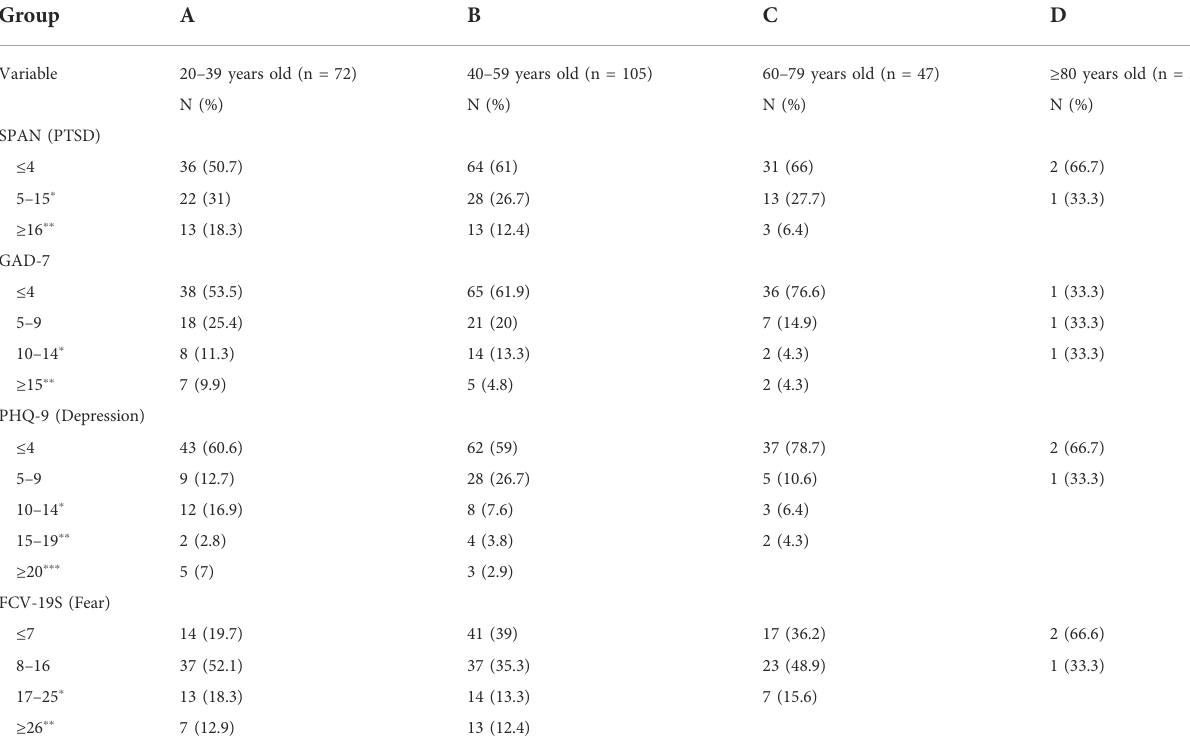
TABLE 1 Prevalence of PTSD, anxiety, depression, and fear according to age group.